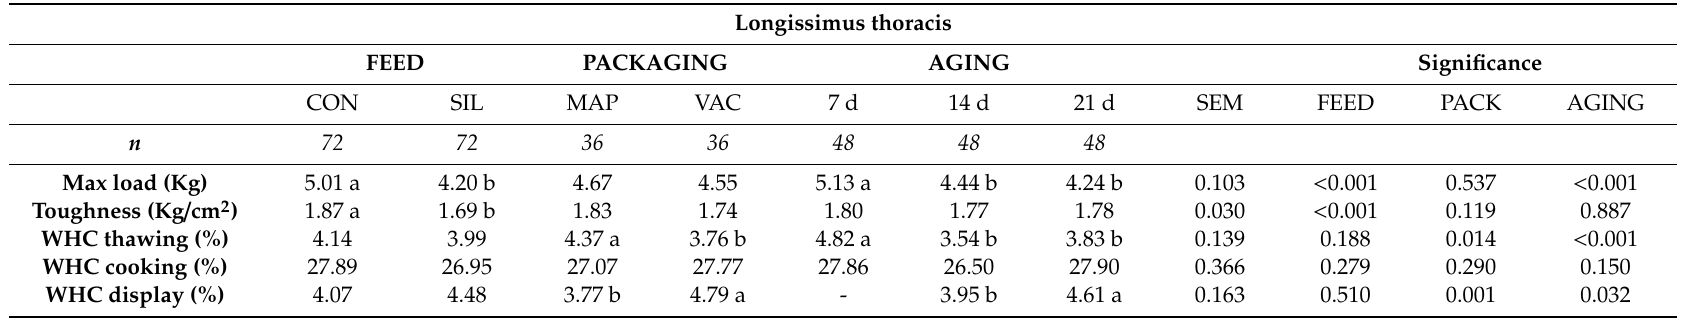
Table 5. E ff ect of feeding (concentrate (CON) vs. 70% maize silage + 30% concentrate (SIL)) and packaging (vacuum (VAC) and modified atmosphere (MAP)) and aging (7, 14 and 21 days) on texture parameters (maximum load and toughness) water holding capacity (WHC) of thawing, cooking and display of Longissimus thoracis muscle of meat from Avileña-Negra Ib é rica breed and significance of e ff ect of feeding (FEED), packaging (PACK) and aging (AGING). Longissimus thoracis FEED